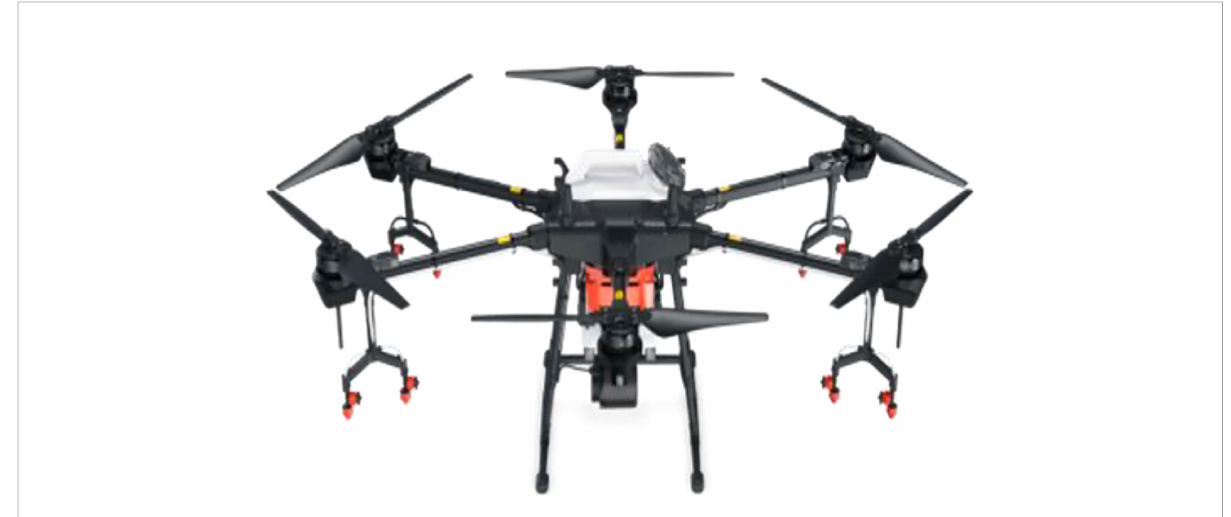
FIGURE 3 T16 six-rotor plant-protection